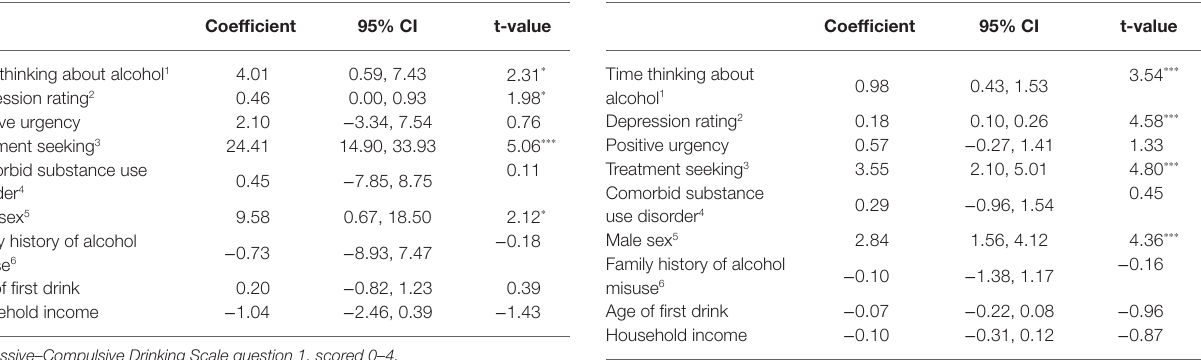
TABLE 4 | Number of high-intensity binge occasions linear model. TABLE 5 | Average drinks per binge occasion linear